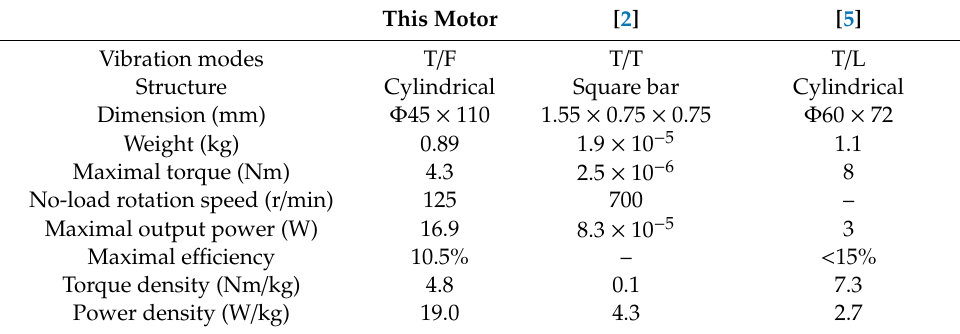
Table 3. Performance comparison between our motor and those driven with torsional